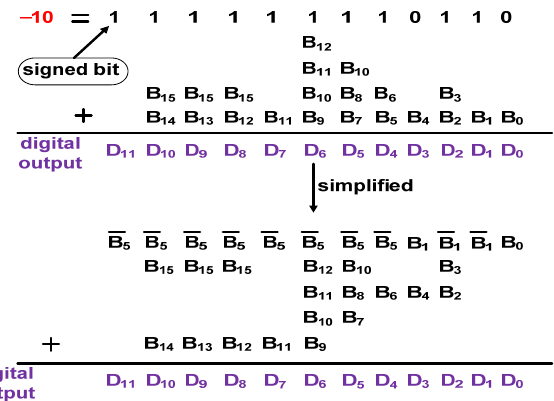
Figure 11. Digital error correction logic.